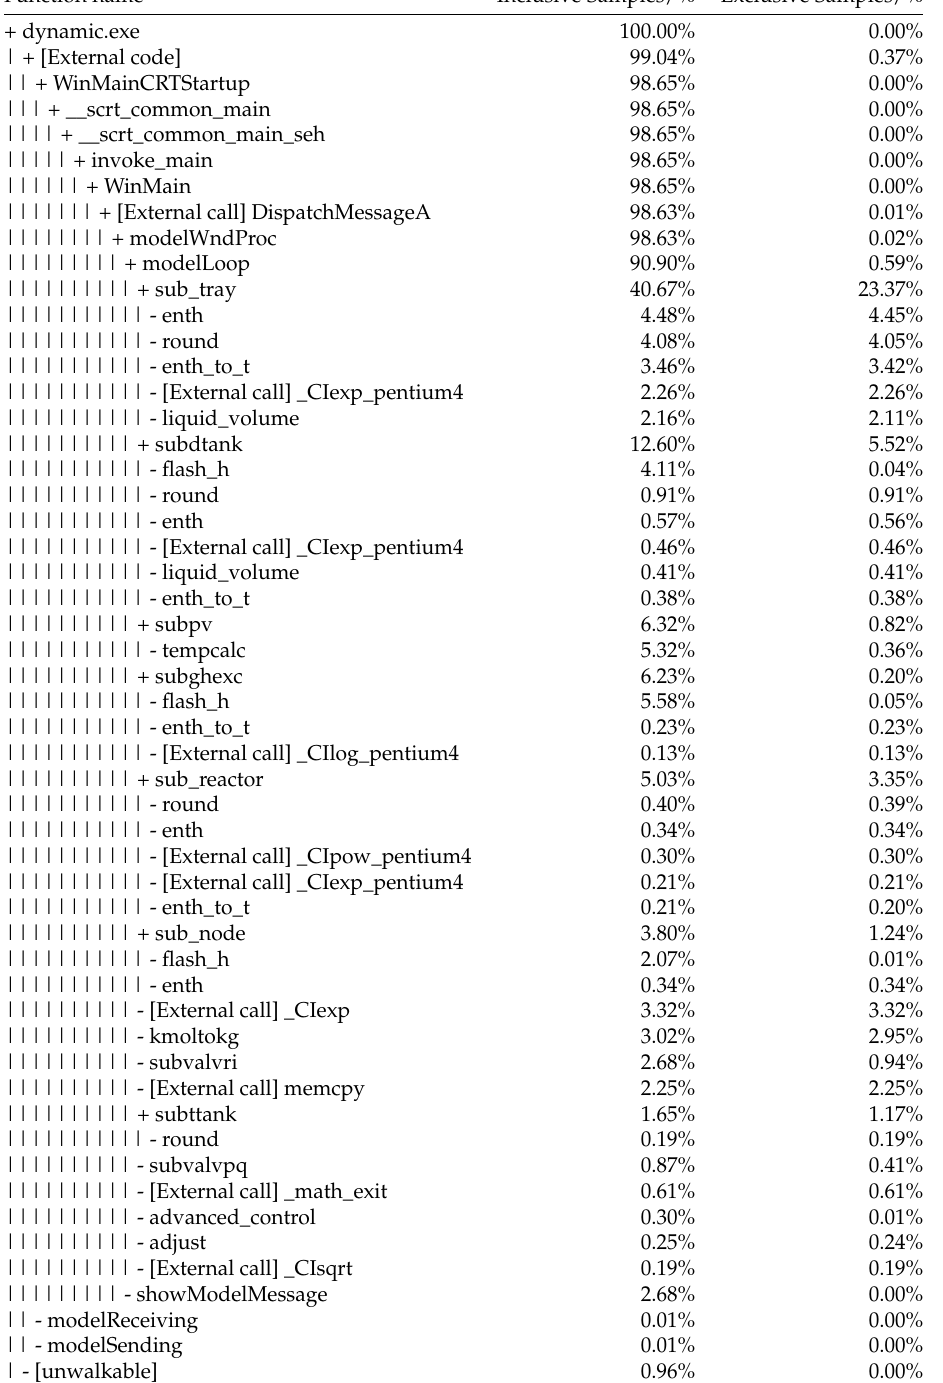
Figure 3. The debug call tree of original program. Some functions with low time cost have been